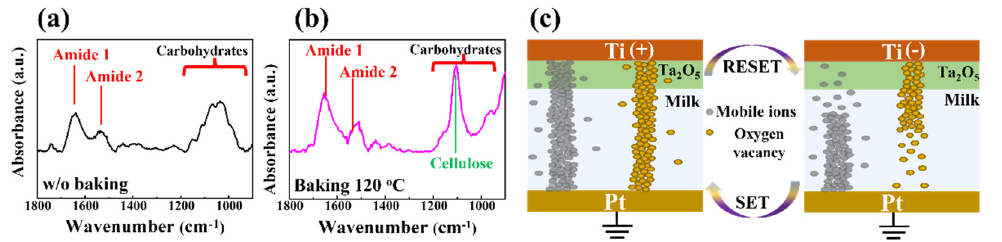
Figure 2. FT-IR spectra of the milk films ( a ) before and ( b ) after baking at 120 °C. ( c ) Simplified filament formation and rupture mechanism.